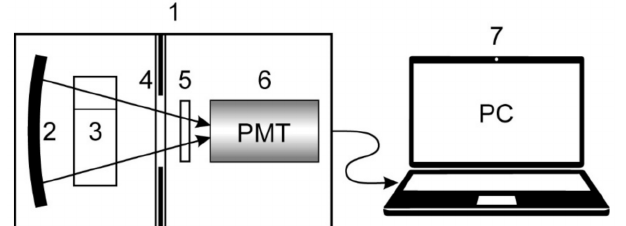
Figure 1. Scheme of the setup for measuring chemoluminescence of protein solutions: (1) Biotox-7A chemoluminometer; (2) focusing mirror; (3) cell with protein solution; (4) photo shutter; (5) optical filter; (6) photomultiplier tube; (7) personal